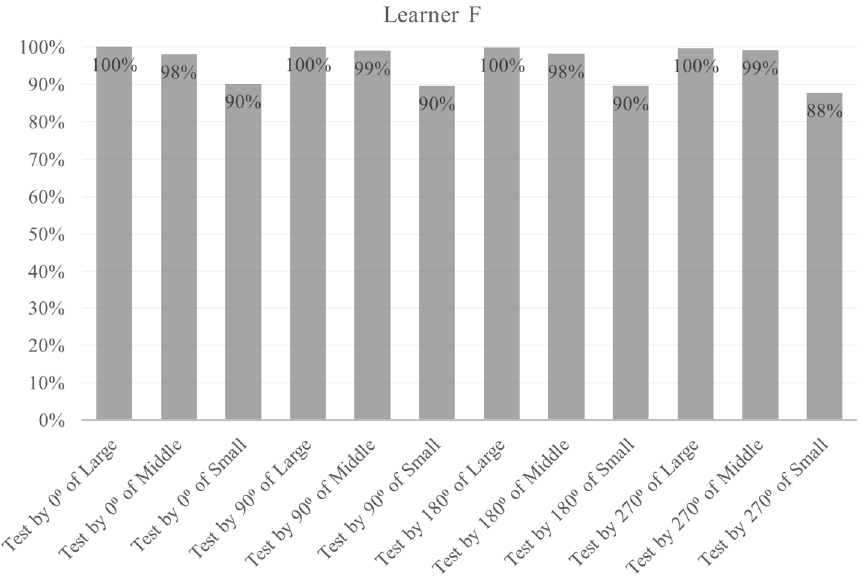
Figure 8. Accuracy of determination over seven classes for Learner